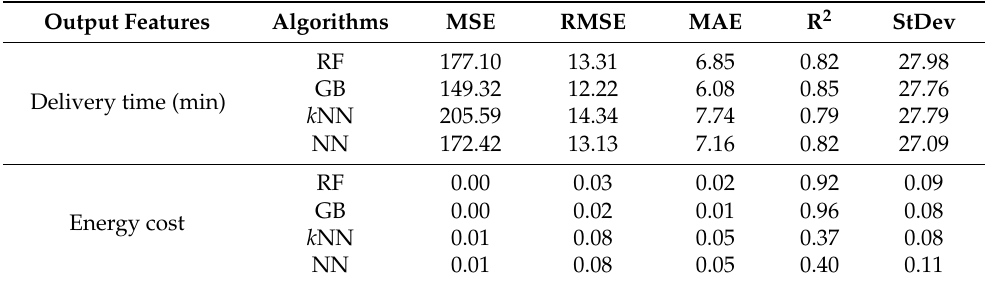
Table 7. The results of performance evaluation metrics result based on prediction stages.